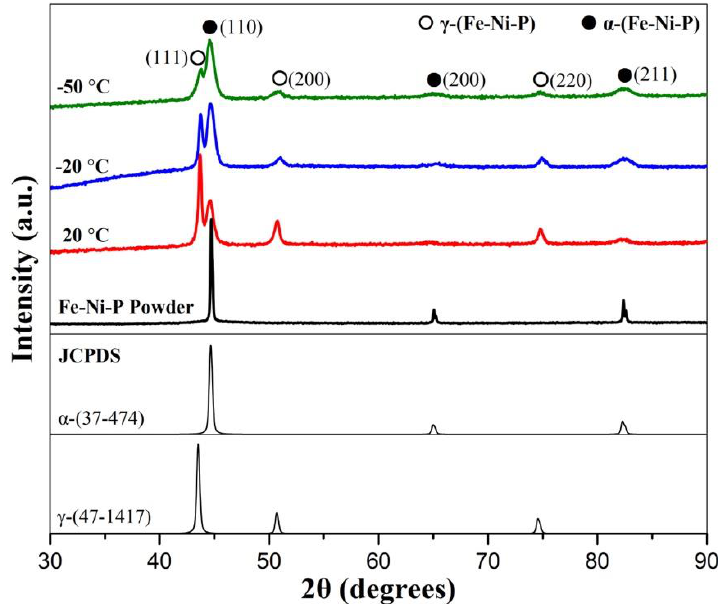
Figure 1. XRD patterns of Fe-Ni-P powder, Fe-Ni-P alloys before/after cryogenic treatment.